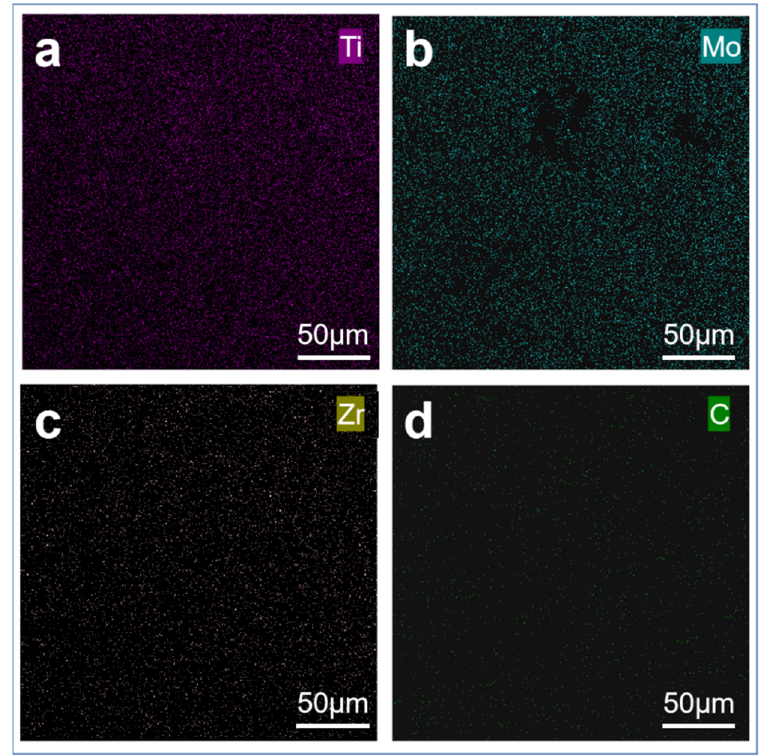
Figure 9. SEM elemental mapping of the Ti-30Mo-0.5TiC-12Z alloy of the area in Figure 8d: ( a ) Ti, ( b ) Mo, ( c ) Zr, and ( d ) C distribution.